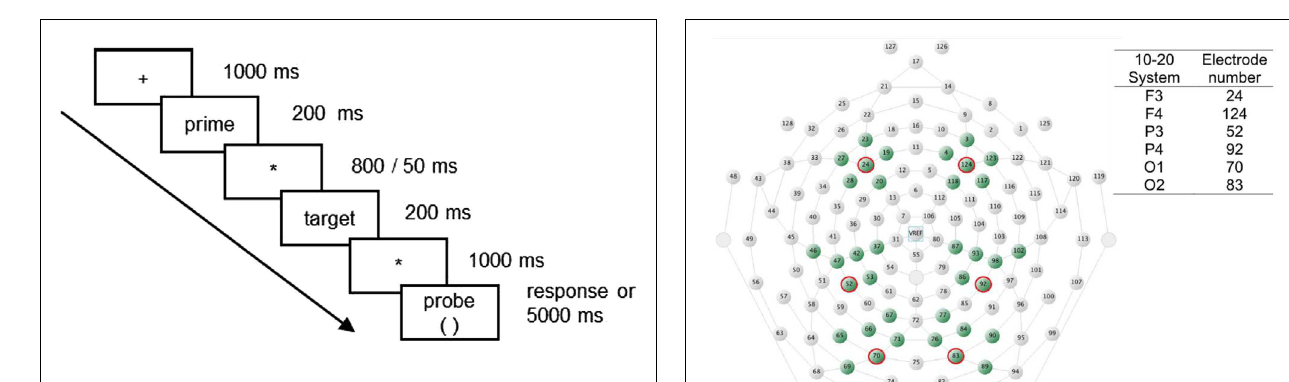
FIGURE 1 |The ERP paradigm.